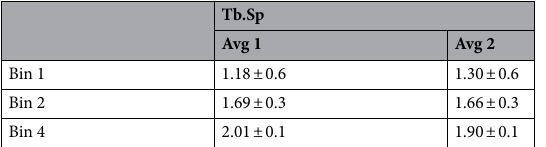
Table 6. Mean and standard deviation of Tb.Sp values, according to frame averaging (Avg 1 or Avg 2) and data binning (Bin 1, Bin2, and Bin 4).